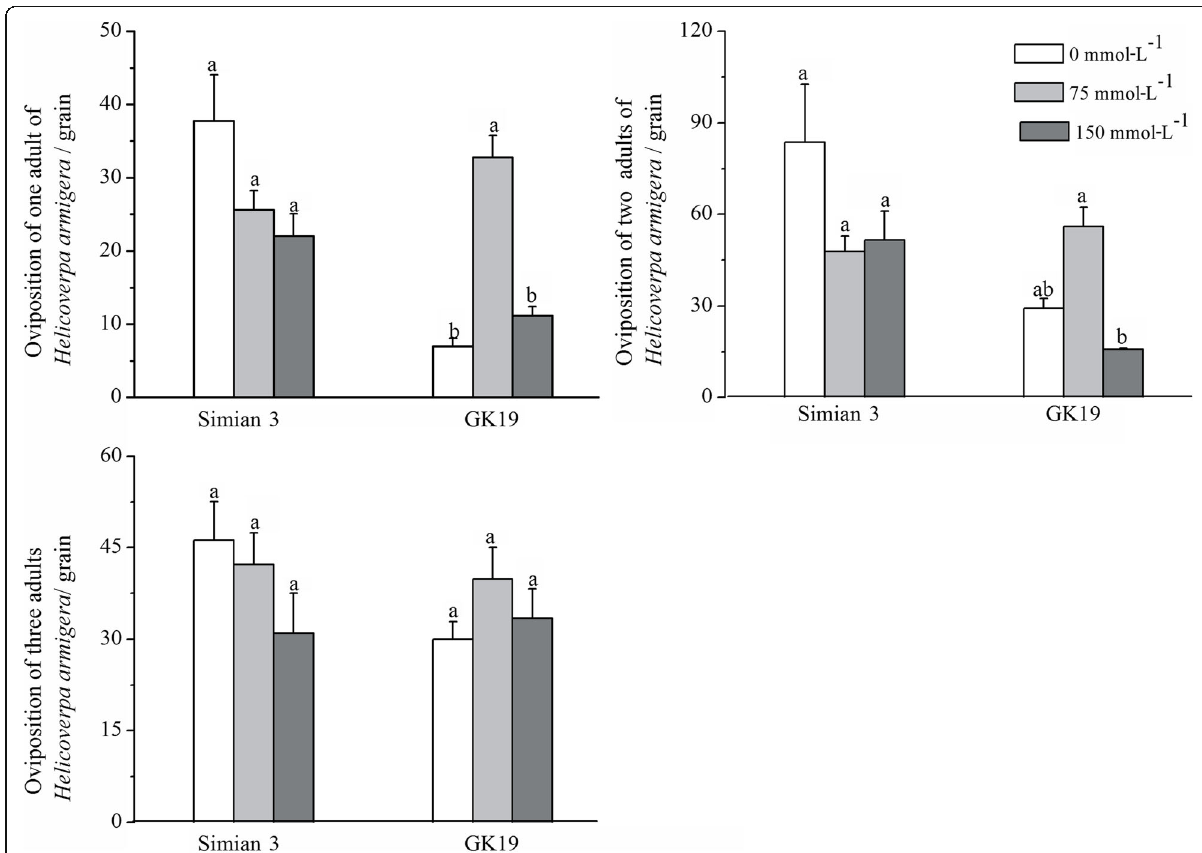
Fig. 6 Adult oviposition host selectivity of H. armigera fed leaves of GK19 and Simian 3 plants grown under NaCl stress. Mean ± (SE); Significant difference in lowercase letters at 0.05 level between NaCl stress